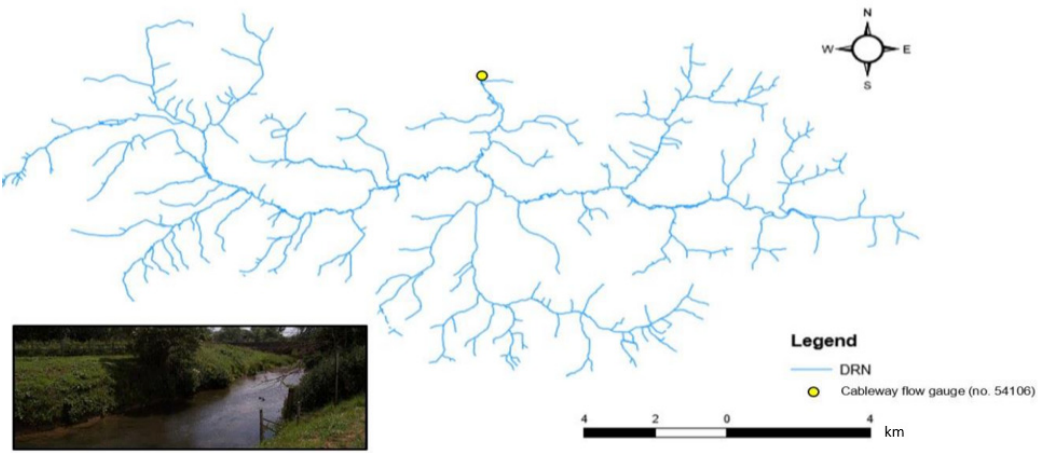
Figure 2. Station Gauge in Shipston-on-Stour (no. 54,106).